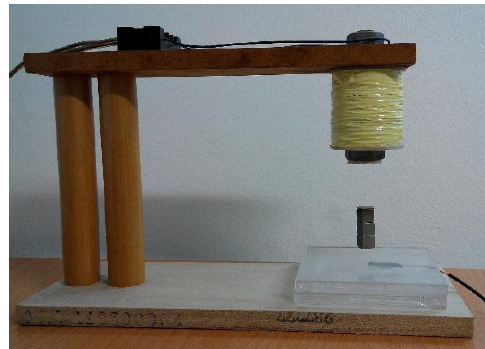
Figure 9. Picture of a FSMSS.